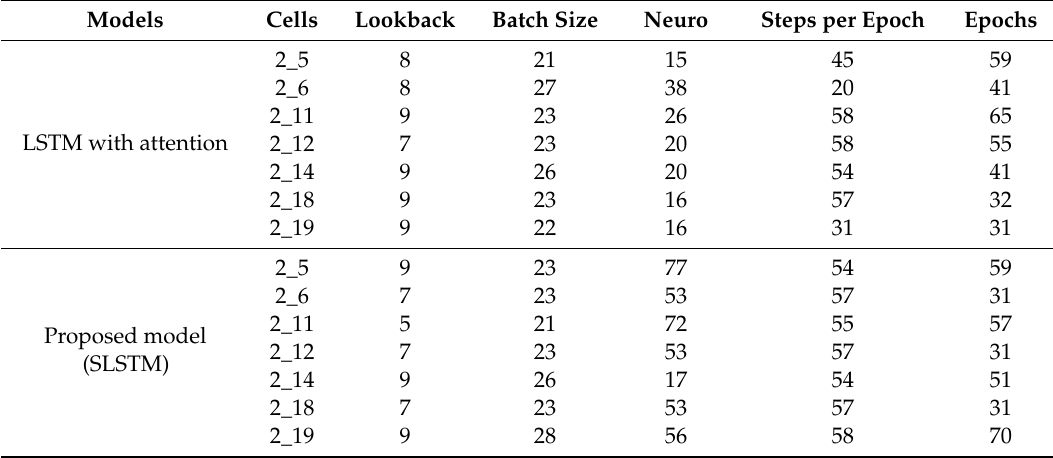
Table 2. Optimal parameters of long short-term memory (LSTM) with attention model and stacked long short-term memory (SLSTM)